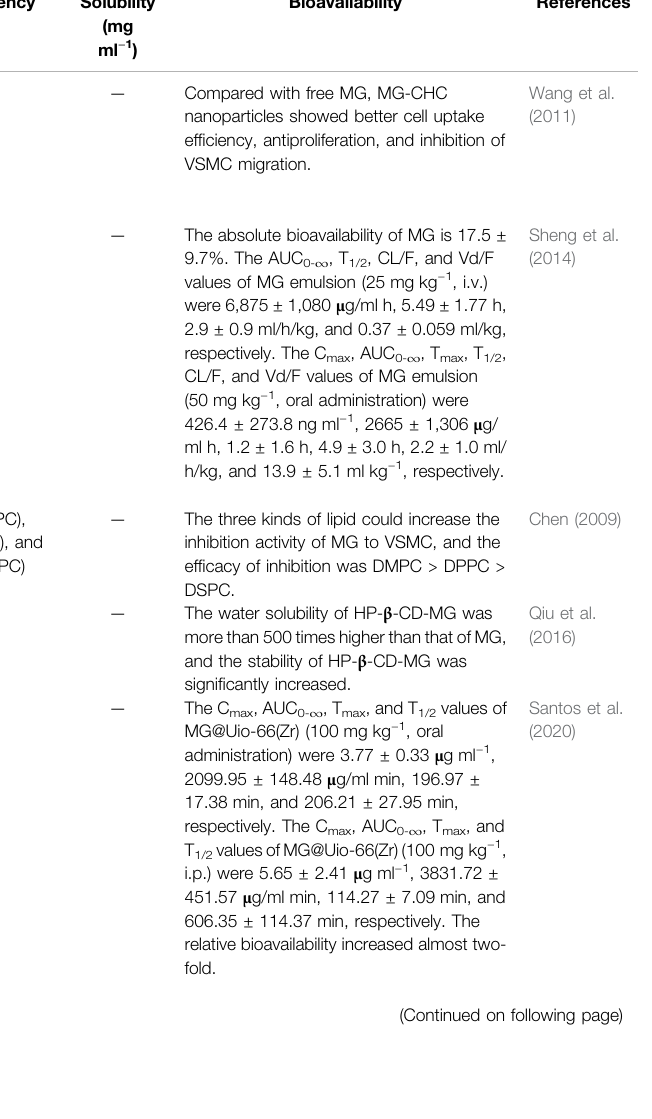
Wang et al. (2011)